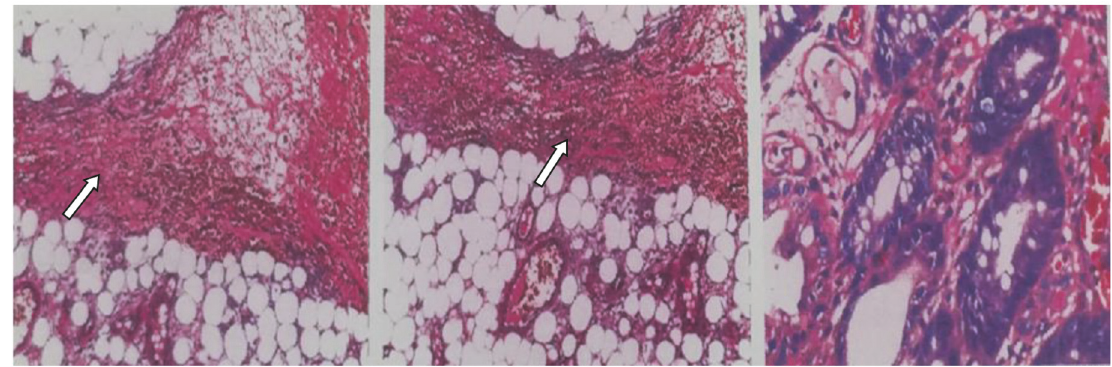
Figure 5: Histological finding of